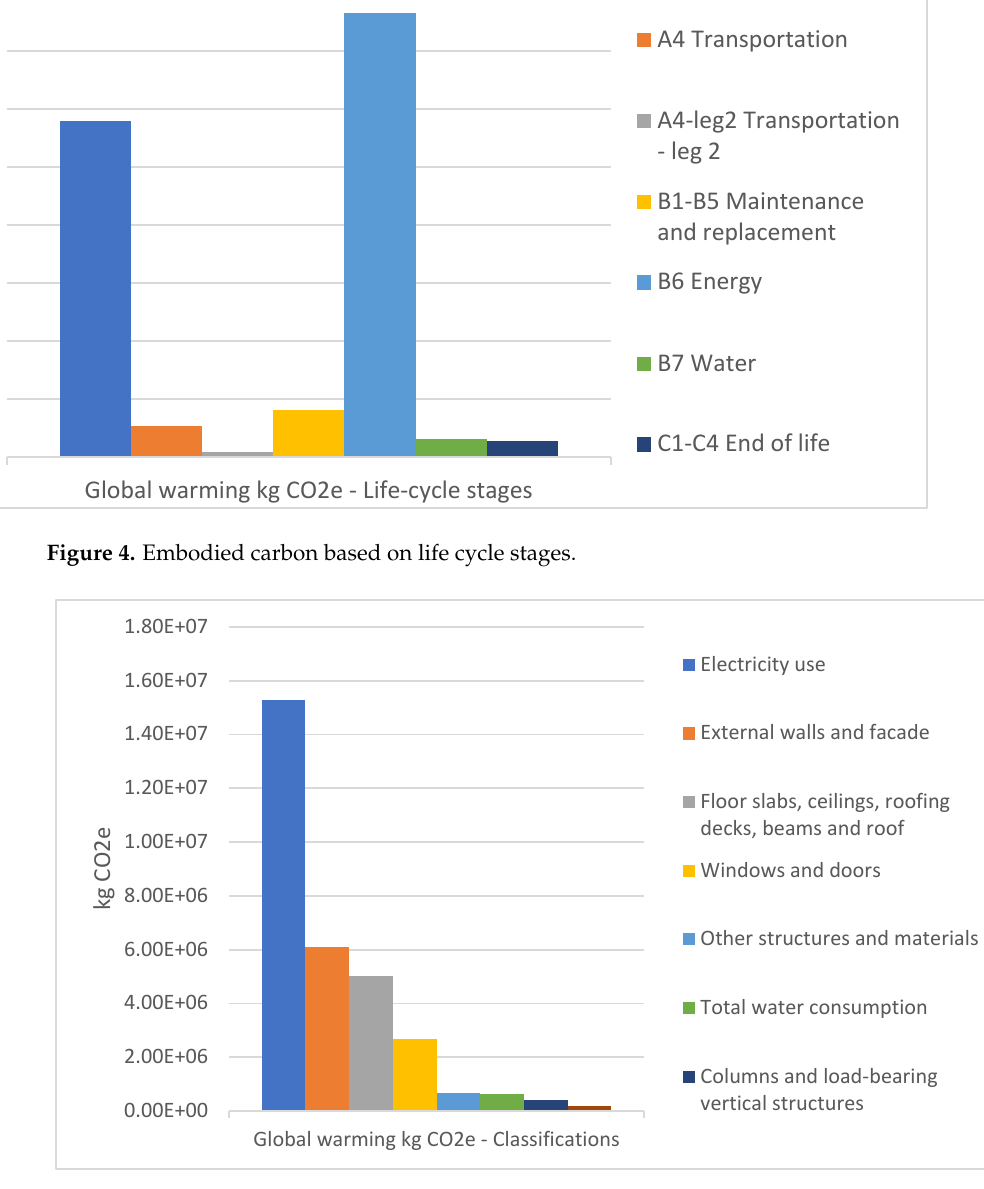
Figure 5. Embodied carbon based on element classification.